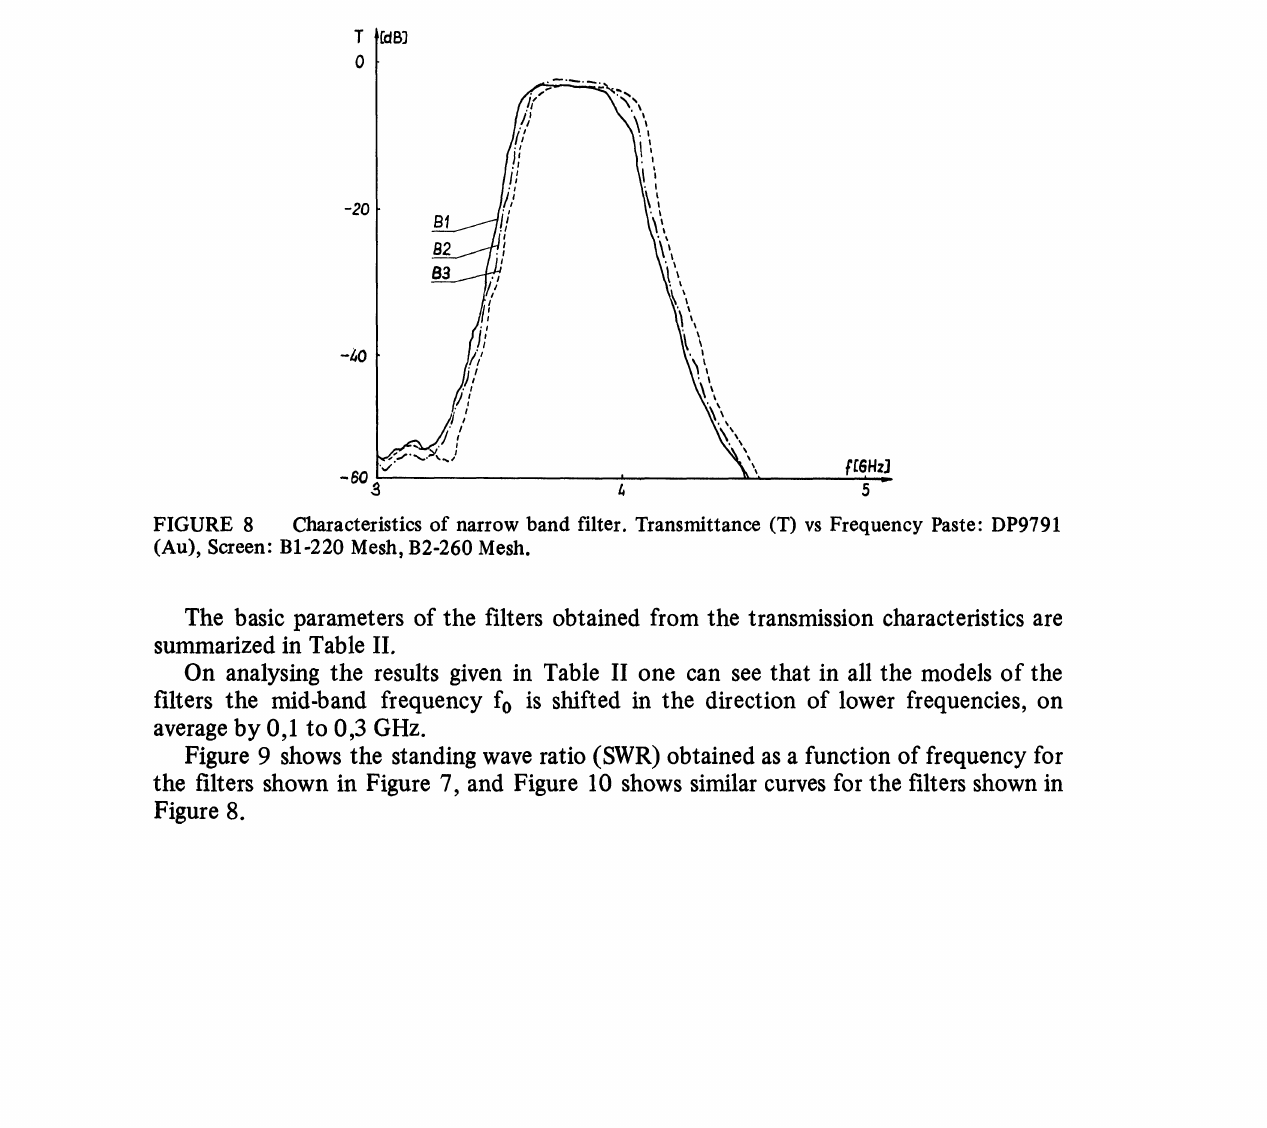
FIGURE 7 Characteristics of narrow band filters. Transmittance (T) vs Frequency Paste: DP9770 (Pt-Ag), Screen A1-220 Mesh, A2-260 Mesh, A3-330 Mesh. 0